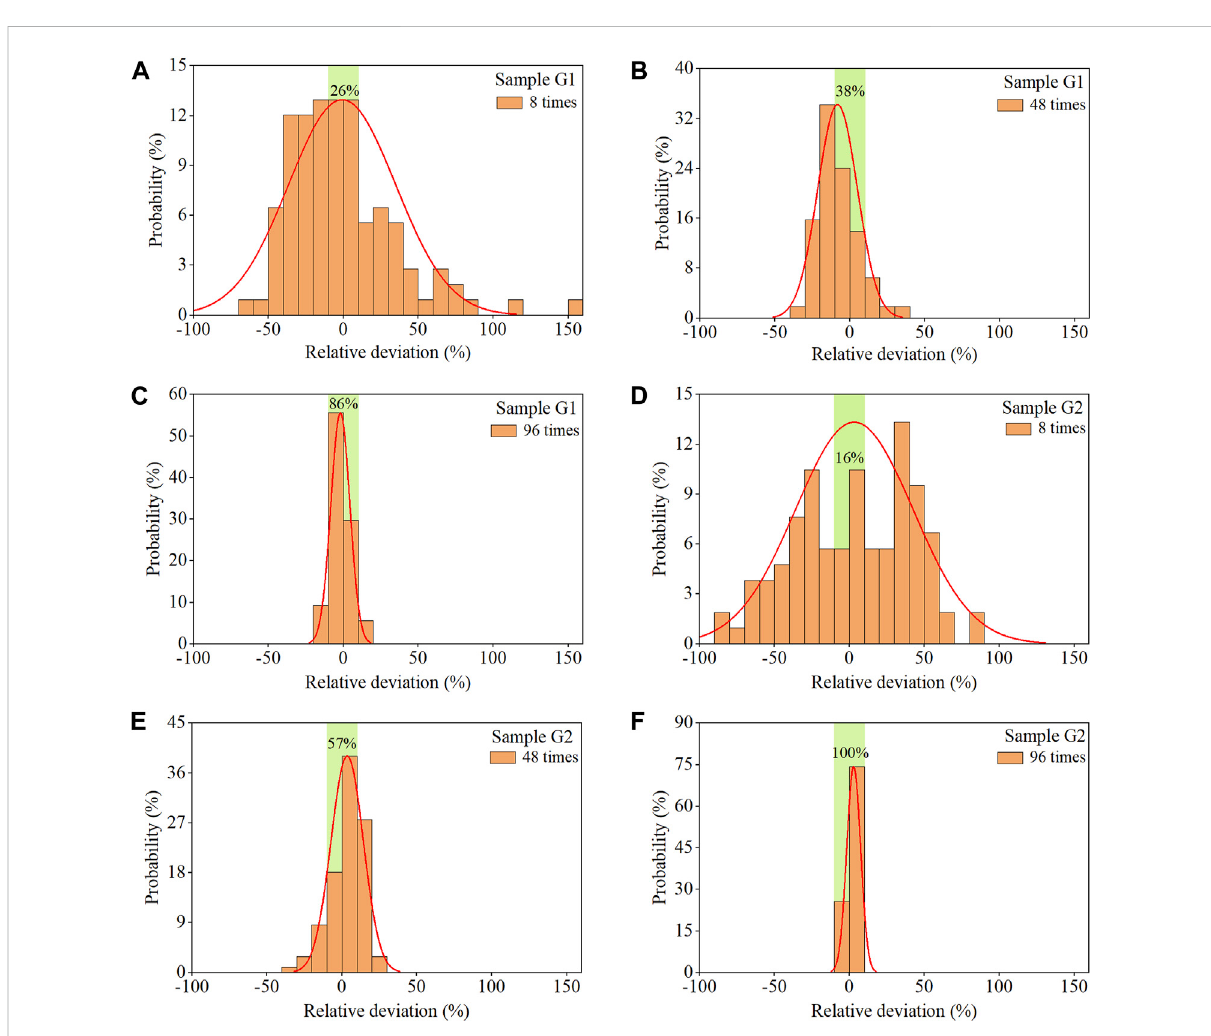
FIGURE 8 Probability distribution of relative deviations to the average porosity, for models upsized by 8 times (A,D) , 48 times (B,E) and 96 times (C,F) of samples G1 and G2, respectively.